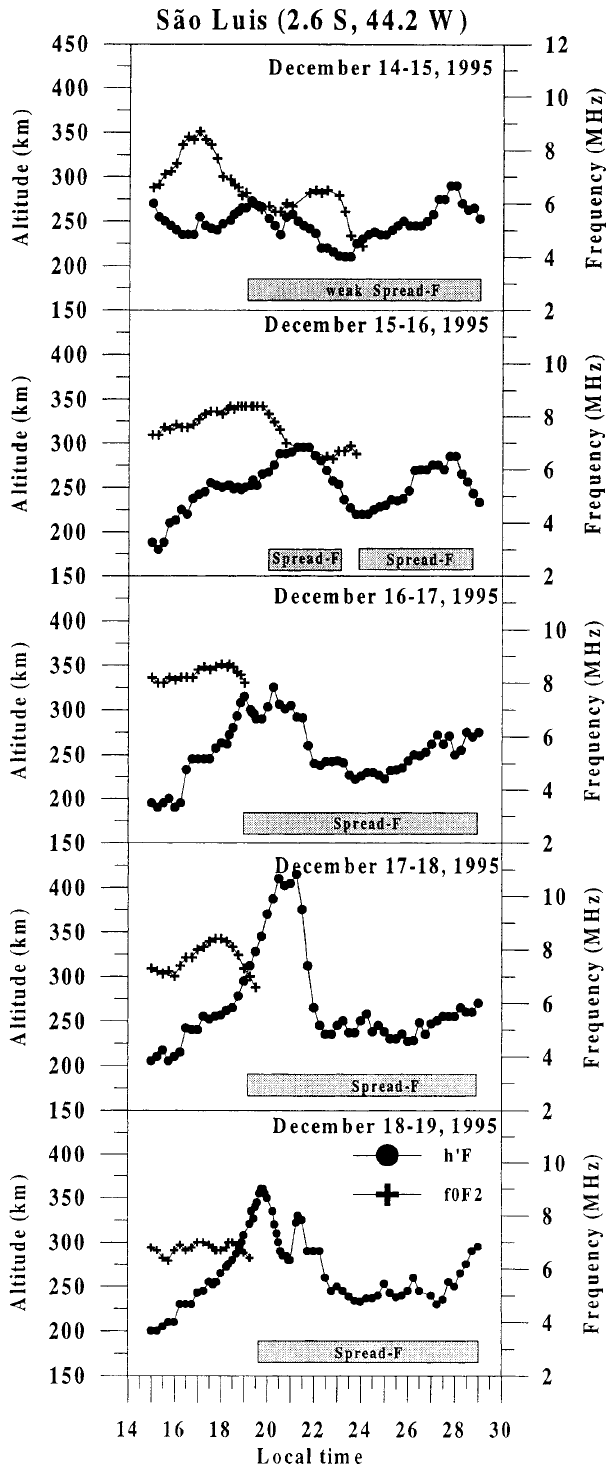
Fig. 6A–E. Local time variations of the ionospheric parameters h ¢ F and f oF2 obtained at Sa˜ o Luis (2.6 (cid:176) S, 44.2 (cid:176) W) for all nights